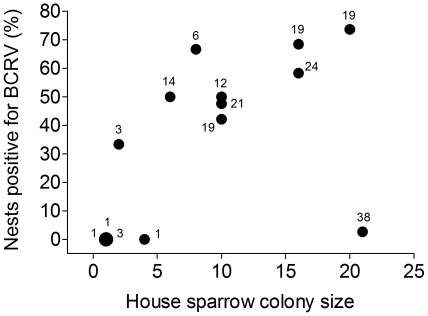
Percentage of house sparrow nests with ≥ 1 nestling positive for BCRV at a site in relation to house sparrow colony size (maximum number of simultaneously active nests).The percentage of positive nests increased with colony size (n = 14 colonies; rs = 0.69, p = 0.006). Sample sizes (number of nests) for each colony are shown near the symbols; sample size includes re-nestings and second broods, yielding values higher than the colony size in some cases. The large circle represents three colonies with the same value.